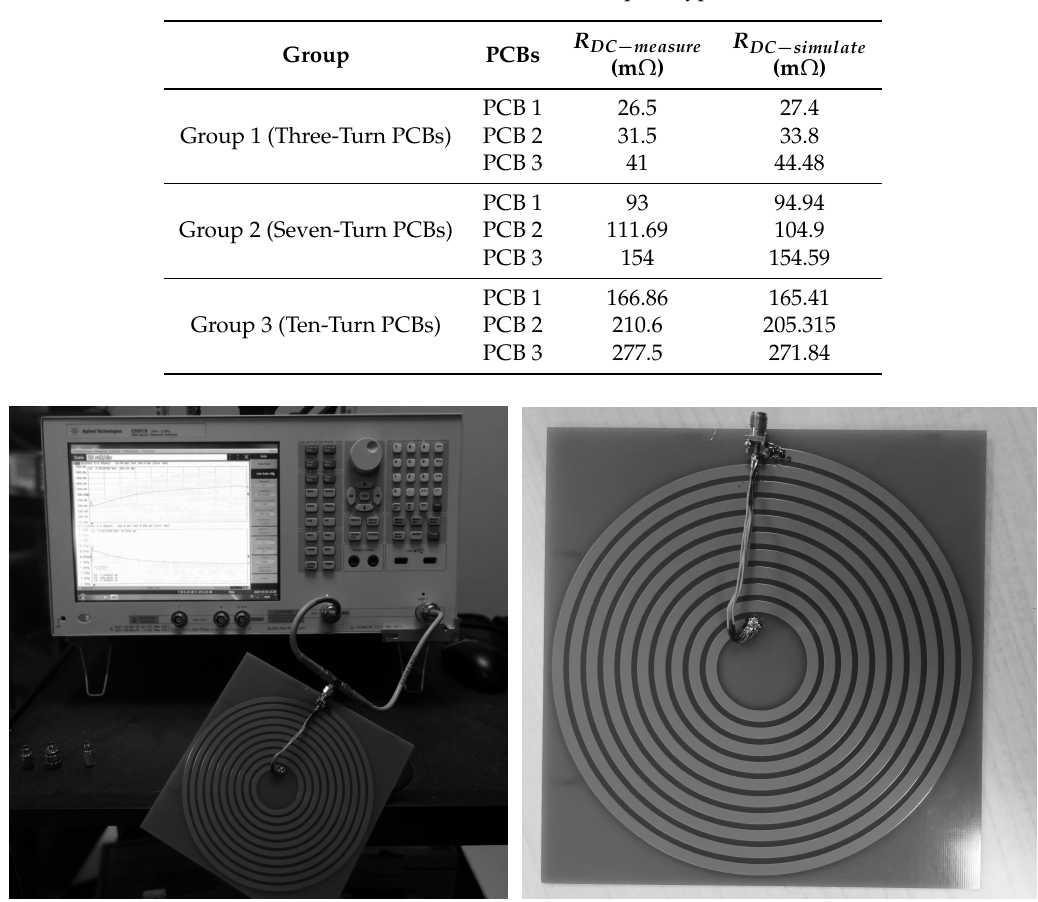
Table 6. DC resistances of PCB prototypes